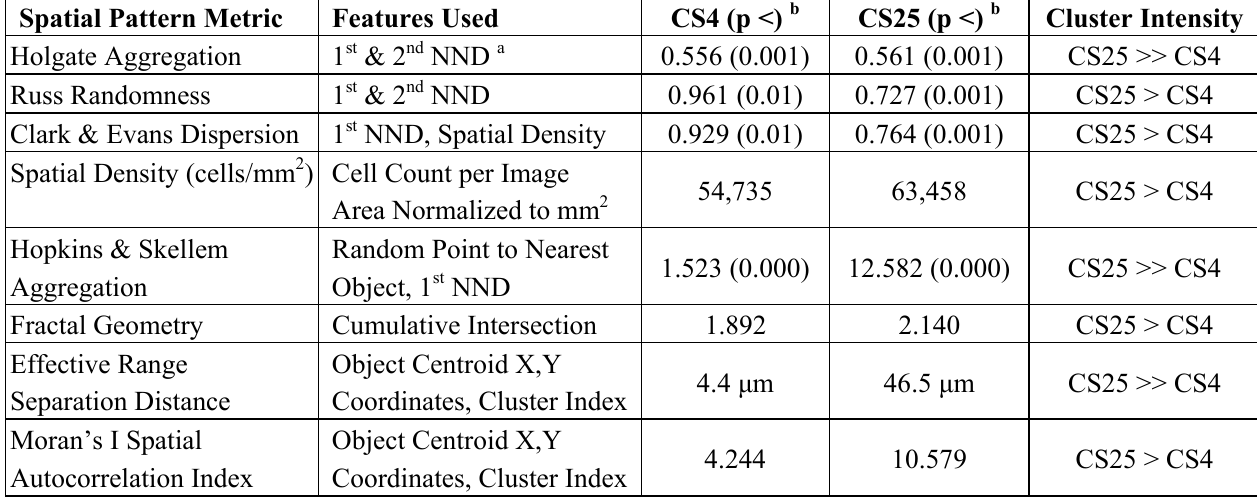
Table 2. Ecological statistics to test if the microbial distribution in the CS4 and CS25 biofilms deviate from complete spatial randomness, and compare the intensity of spatial aggregation in their colonization